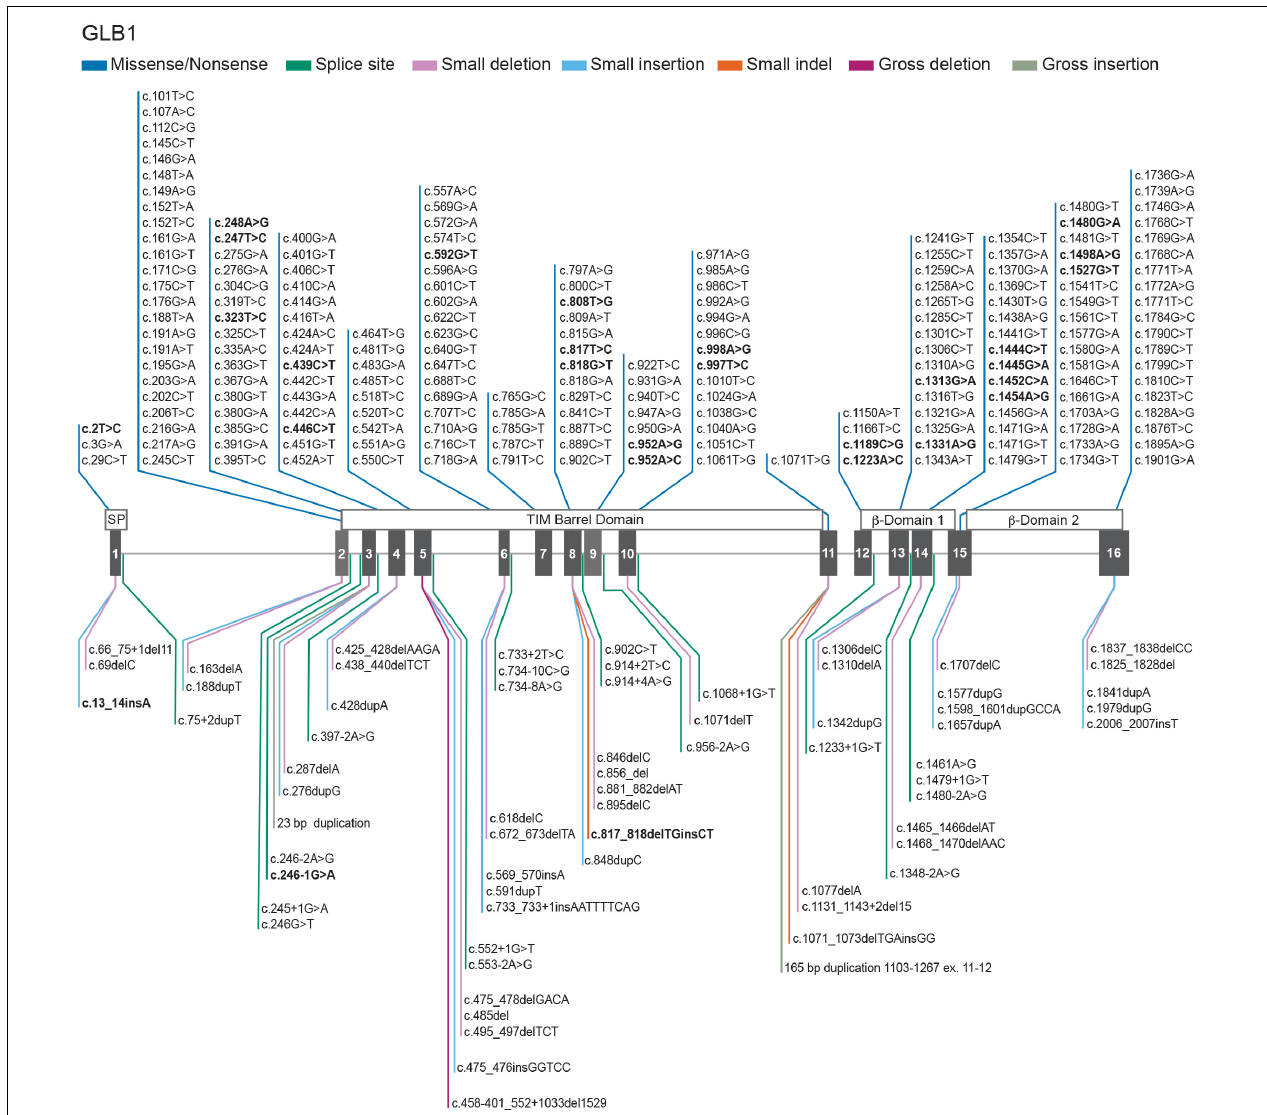
FIGURE 2 | Genotypes in GM1 gangliosidosis. Schematic representation of 261 GLB1 variants with a reported phenotype of GM1-gangliosidosis and/or Morquio B registered in the database HGMD (2021) updated with the novel variants from Tebani et al. (2021). The GLB1 gene is located on the short arm of chromosome 3 (3p21.33). GM1 gangliosidosis and Morquio B disease result from biallelic mutations in GLB1 gene. Mutations affecting the catalytical site of the β -GAL enzyme may reduce or eliminate the degradation of GM1 substrate. GLB1 cDNA sequence NM_000404.4; Ref SeqGene NG_009005.1; 194 Missense/Nonsense (dark blue), 20 Splicing substitutions (dark green), 25 small deletions (pink), 17 small insertion/duplications (light blue), 2 small indels (orange), 1 gross deletion (purple), 2 gross insertion/duplications (light green). Bold text represents GM1 gangliosidosis and/or Morquio B reported phenotypes. A summary of the 261 reported variants with a phenotype of GM1 gangliosidosis and/or Morquio B disease can be found at GLB1 (HGMD, 2021; Tebani et al., 2021). The main domains of the protein are shown above the exons. For a full description on the clinical pathogenicity of each variant the database ClinVar (Landrum et al., 2018) provides information about genomic variation and its relationship to human health at GLB1 (ClinVar,